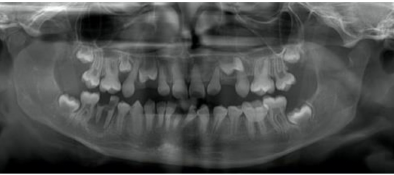
Figure 2. Pulp obliteration, low mineralization density, short roots, bulbous crowns, cervical constric- tion in panoramic